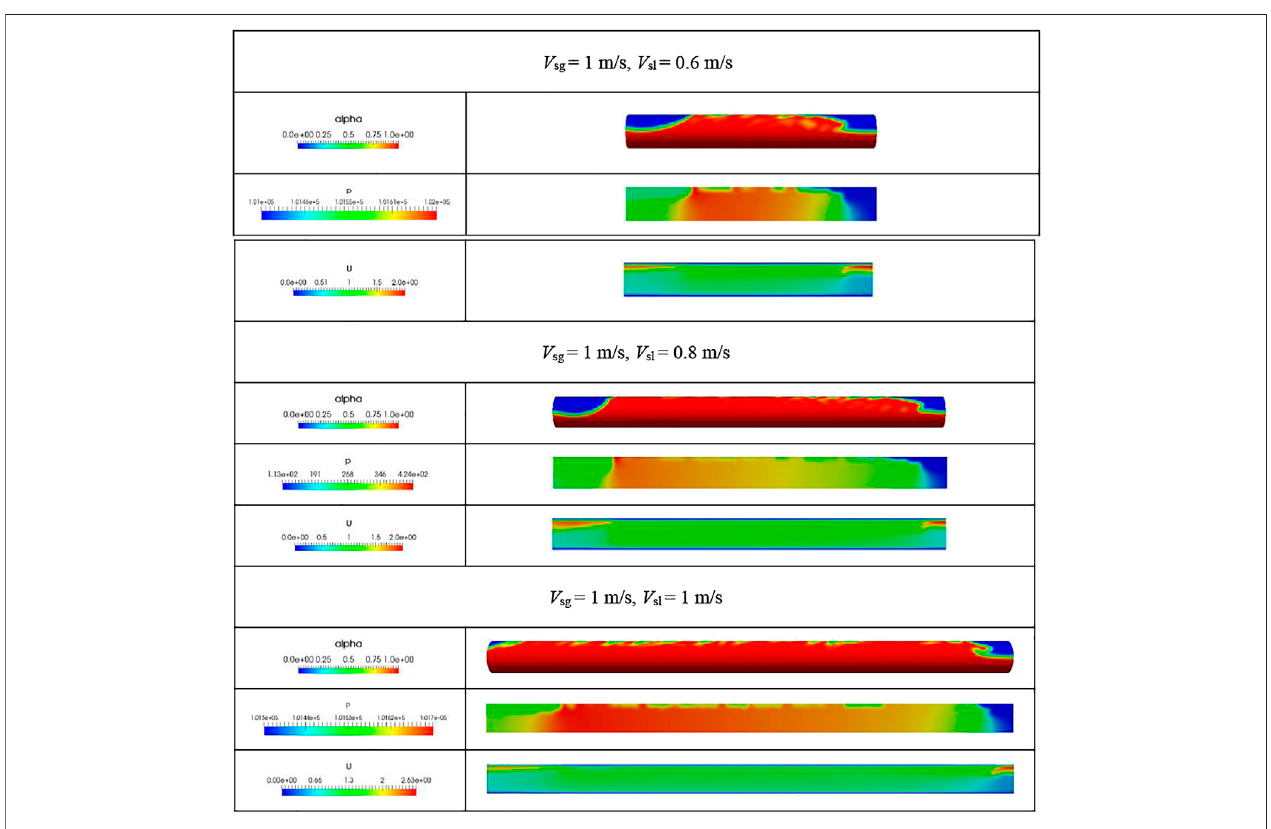
FIGURE 20 | Pressure distribution of a fully-developed slug at different liquid